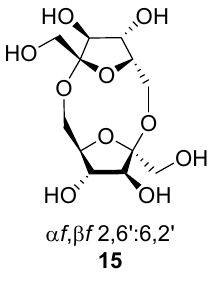
Figure 4 . Structure of the non-spiroacetalic di- β - D -fructofuranose 2,6’:6,2’ dianhydride ( 15 ).